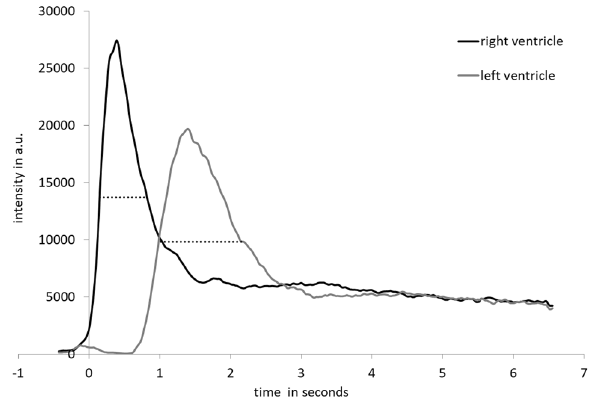
Figure 4. Short bolus profile in the right ventricle and dispersion in the left ventricle measured by magnetic particle imaging: averaged signal to time curves of eight mice show a full width at half maximum of 578 ms ± 144 ms in the right ventricle and 1042 ms ± 150 ms in the left ventricle. After 4 s signal intensities are